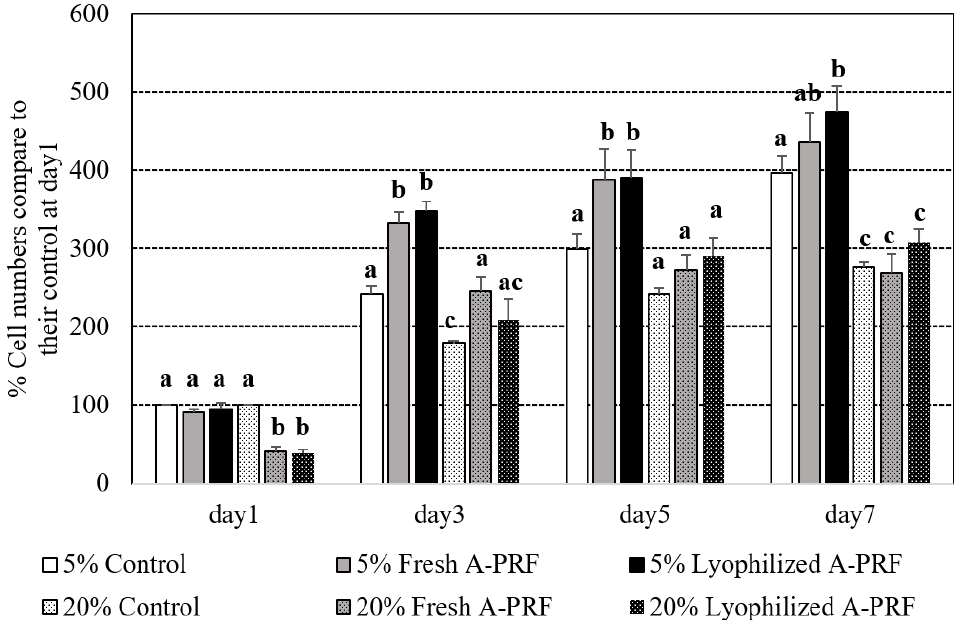
Figure 3. Percentages of different cell proliferation numbers of the standard cultured media supple- mented with 5% and 20% of fresh and lyophilized A-PRF compared to the control media of their supplemented percentages at day 1. a,b,c : different letters indicating significant differences among the control and fresh as well as lyophilized A-PRF within the same day.